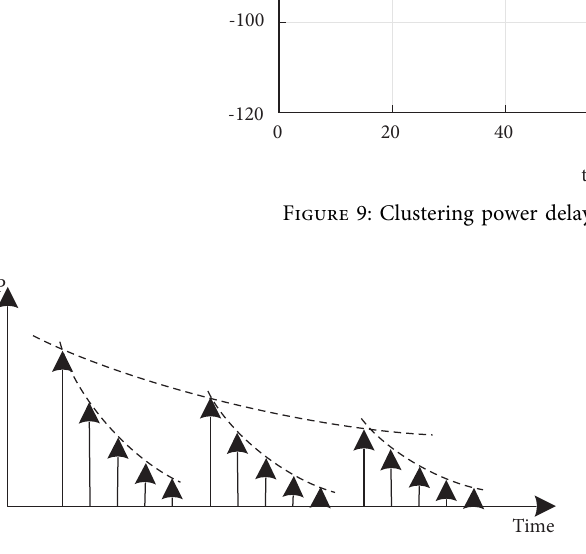
Figure 10: Idealized power delay